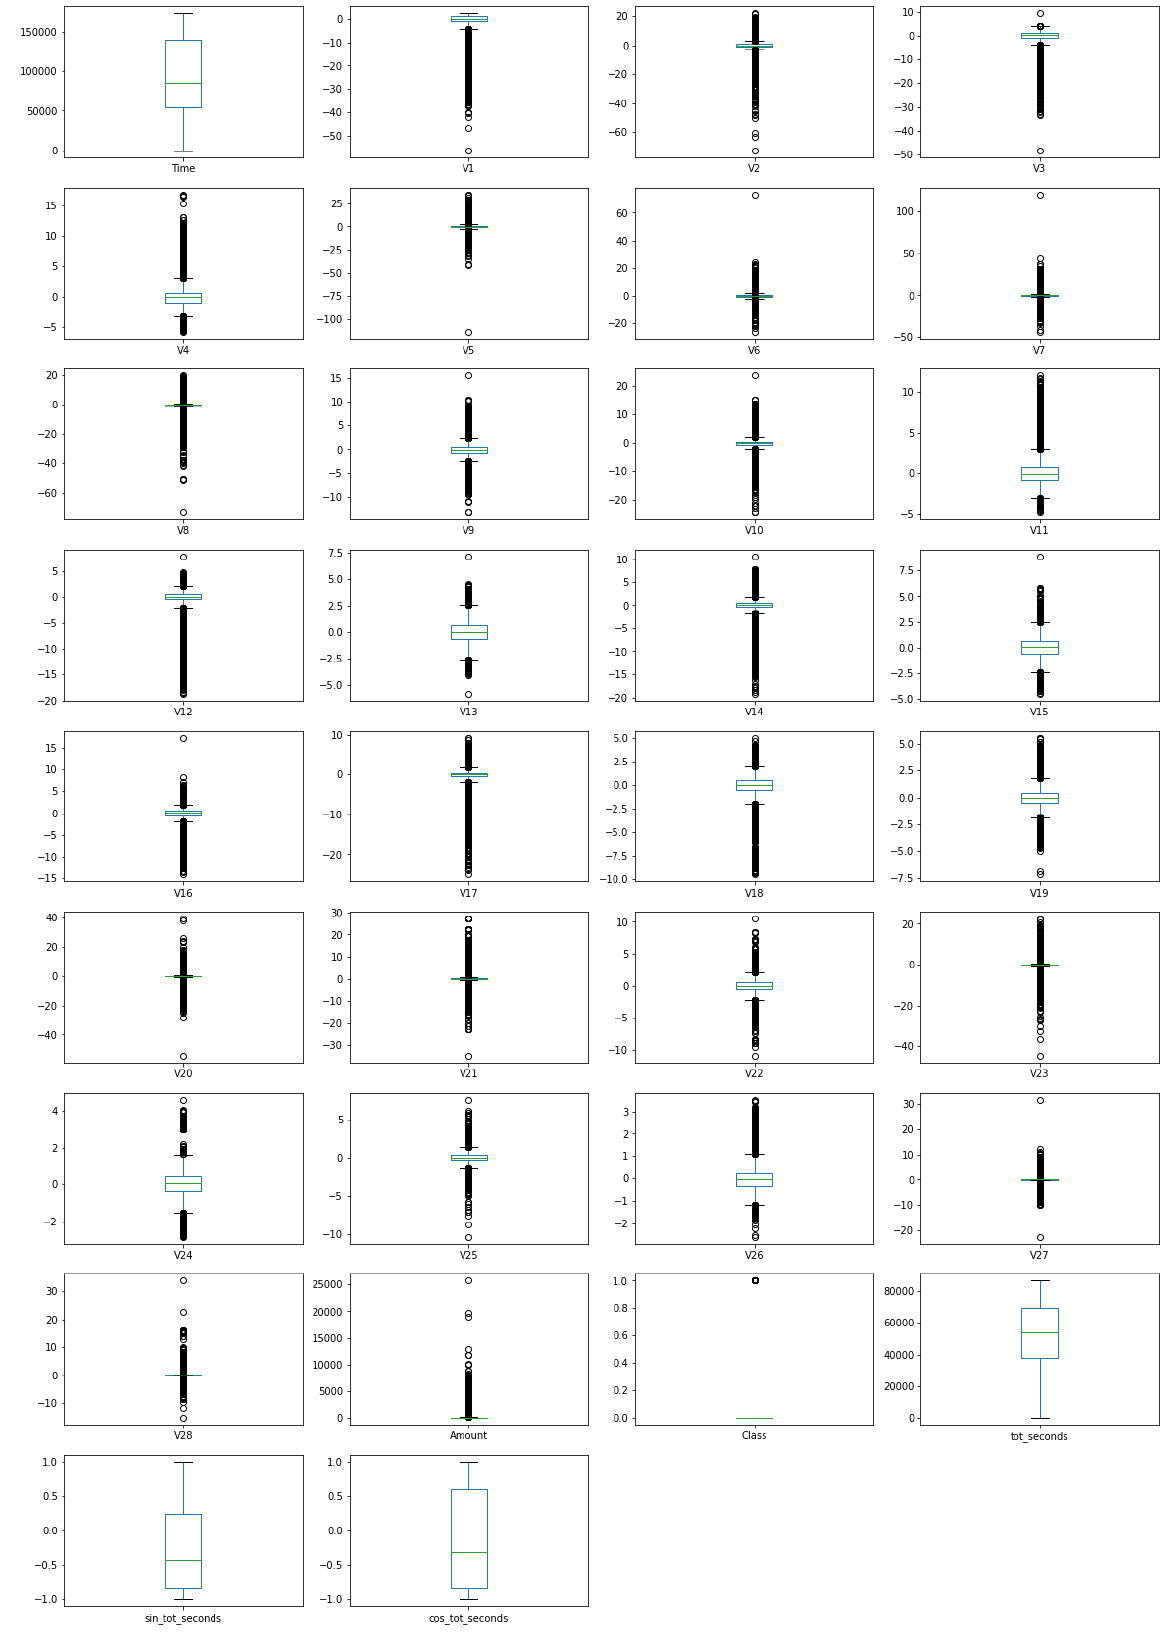
Figure 1. Extended CreditCard dataset box